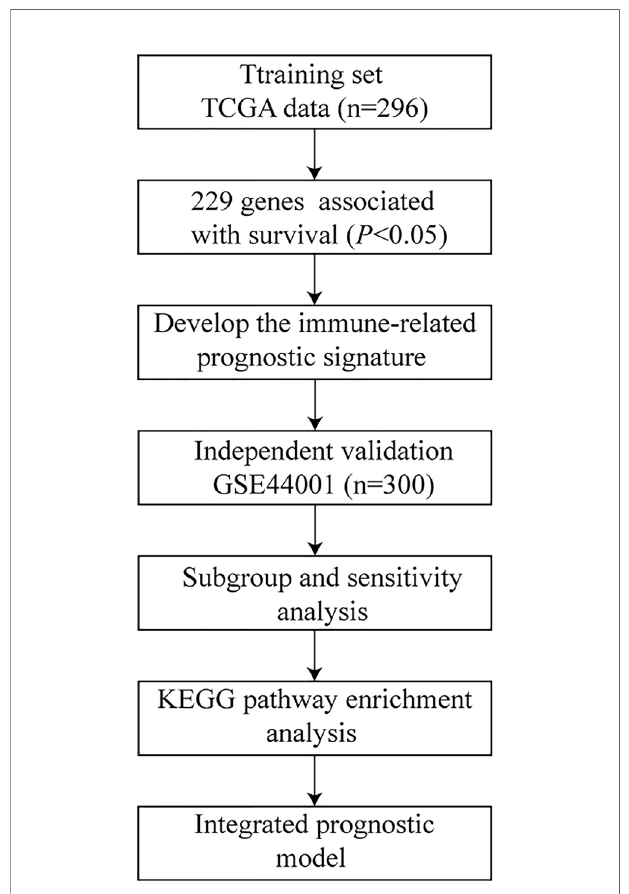
FIGURE 1 | Flowchart of the